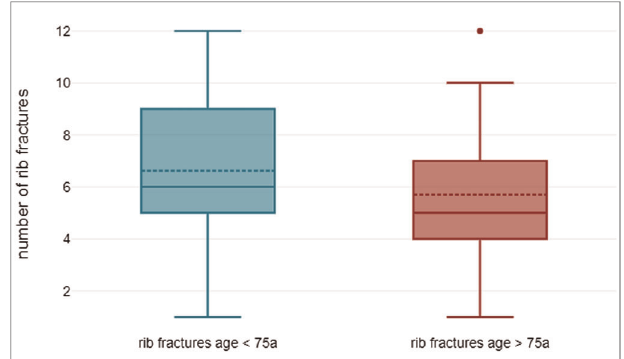
FIGURE 3 | Comparison of rib fractures in younger (<75 years) and older patients (>75 years): mean 7.1 (±2.8) vs. 5.7 (±2.8) ( p